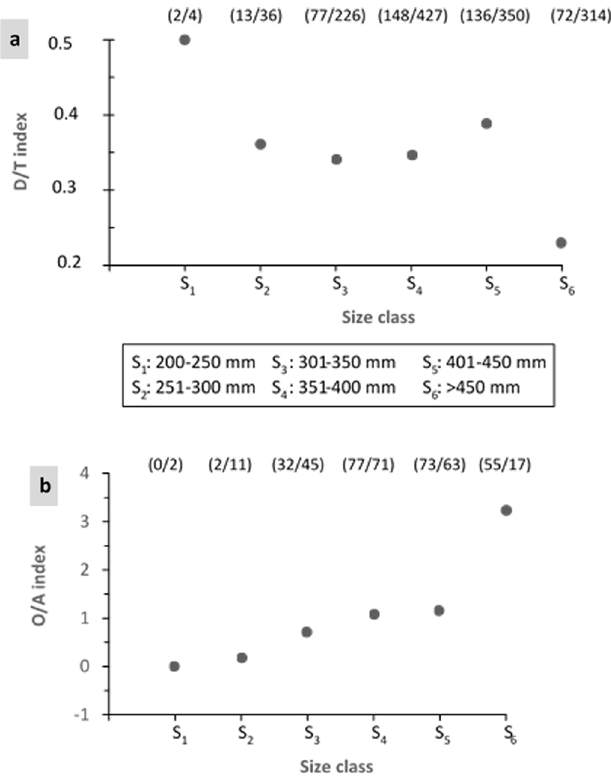
Fig. 4. D/T (a) and O/A indices (b) per size class of tagged yellow eels. The numbers in brackets show the sample sizes of eels detected and eels tagged for the D/T index, and the sample sizes of eels detected in the tagging year and eels detected after the tagging year for the O/A index.